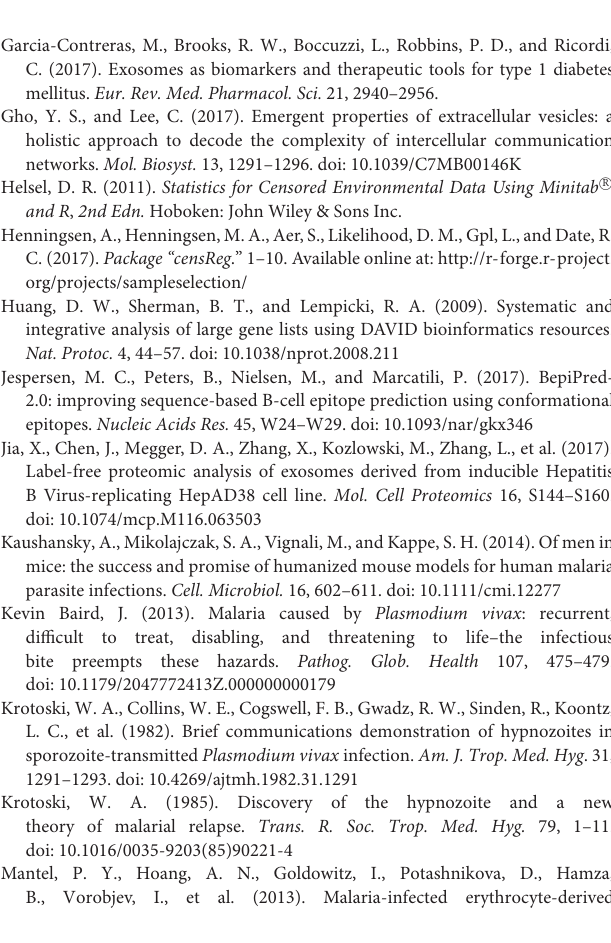
Figure S1 | Experimental P. vivax infection of FRG huHep mice. (A) Six FRG huHep mice were infected with 1 million P. vivax sporozoites. Infected mice were euthanized 8 days post-infection (dpi) and blood samples collected. Four uninfected control mice were also euthanized and blood samples collected. (B) Twelve FRG huHep mice were infected with P. vivax sporozoites and euthanized 8 dpi (four mice), 10 dpi (four mice), 16 dpi (three mice), and 21 dpi (one mouse). After plasma was collected from individual mice, plasma samples from two mice were pooled to generate 2 plasma samples 8 dpi, 2 samples 10 dpi, and 2 samples 16 dpi (1 sample pooled from 2 mice and 1 sample from a single mouse).